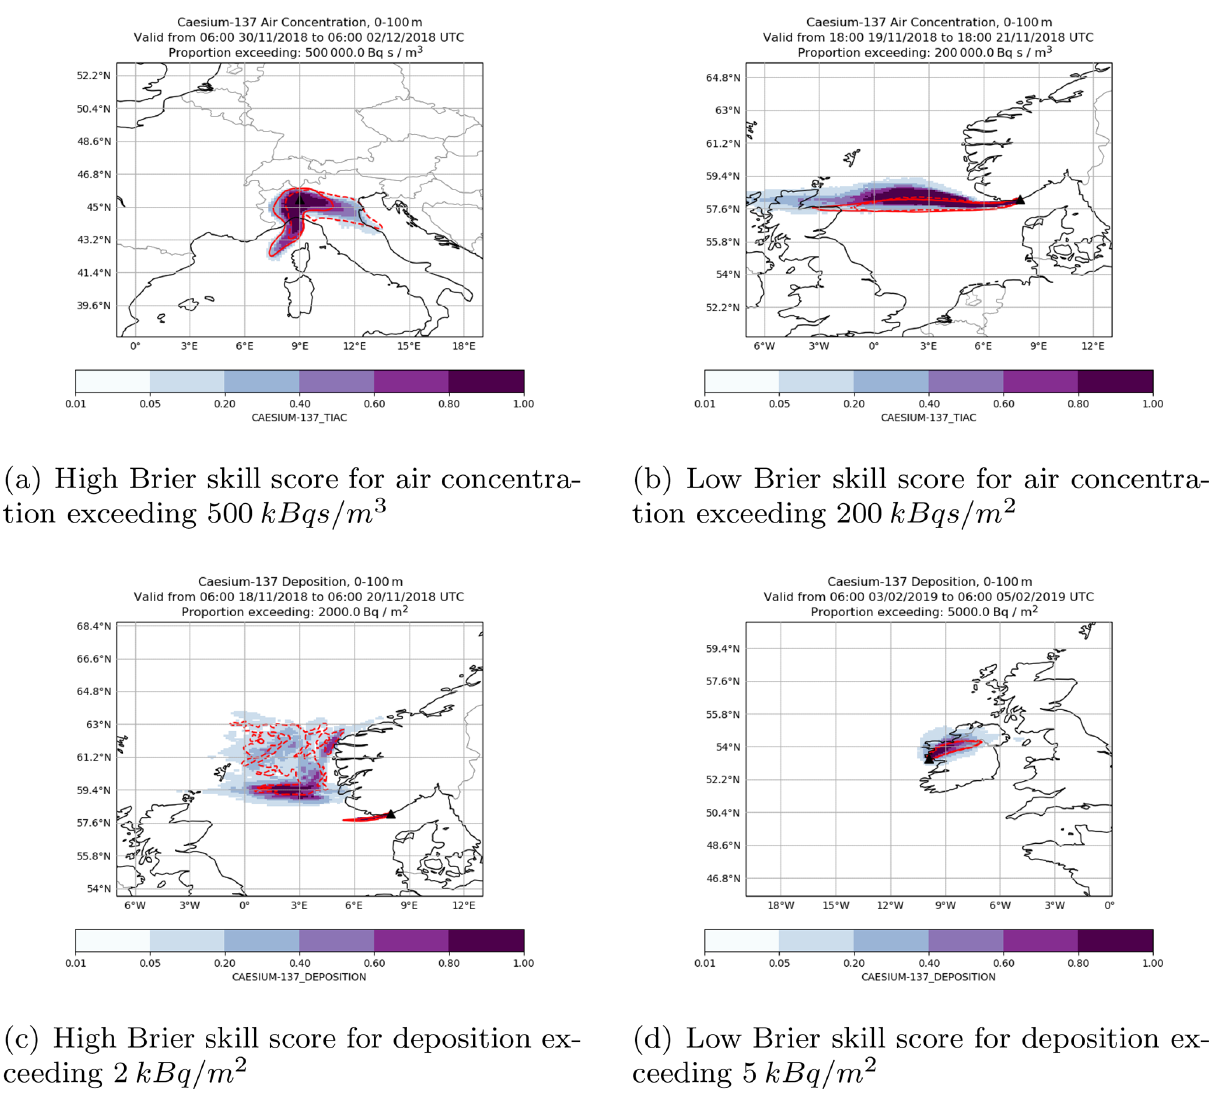
Figure 8. Examples of high and low Brier skill scores from the radiological scenario. The coloured contours show the probability of the ensemble predictions exceeding the threshold. The area where the threshold is exceeded by the analysis simulation is shown by a red solid line and the area where the threshold is exceeded for the deterministic simulation by a red dashed line.